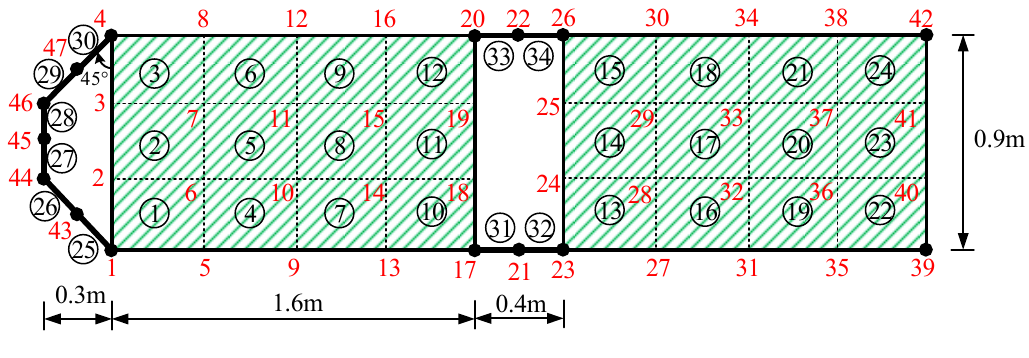
Figure 9. Dimensions of solar wing.